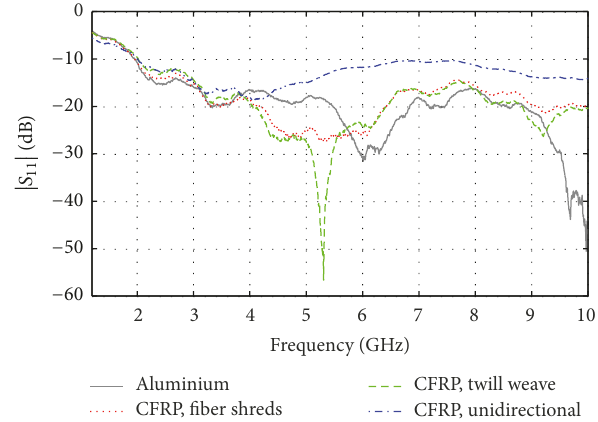
Figure 13: Measured S -parameters of the conical monopole antenna ondifferentgroundplanematerials(reprintedwithpermissionfrom [35]; ©2017 IEEE).